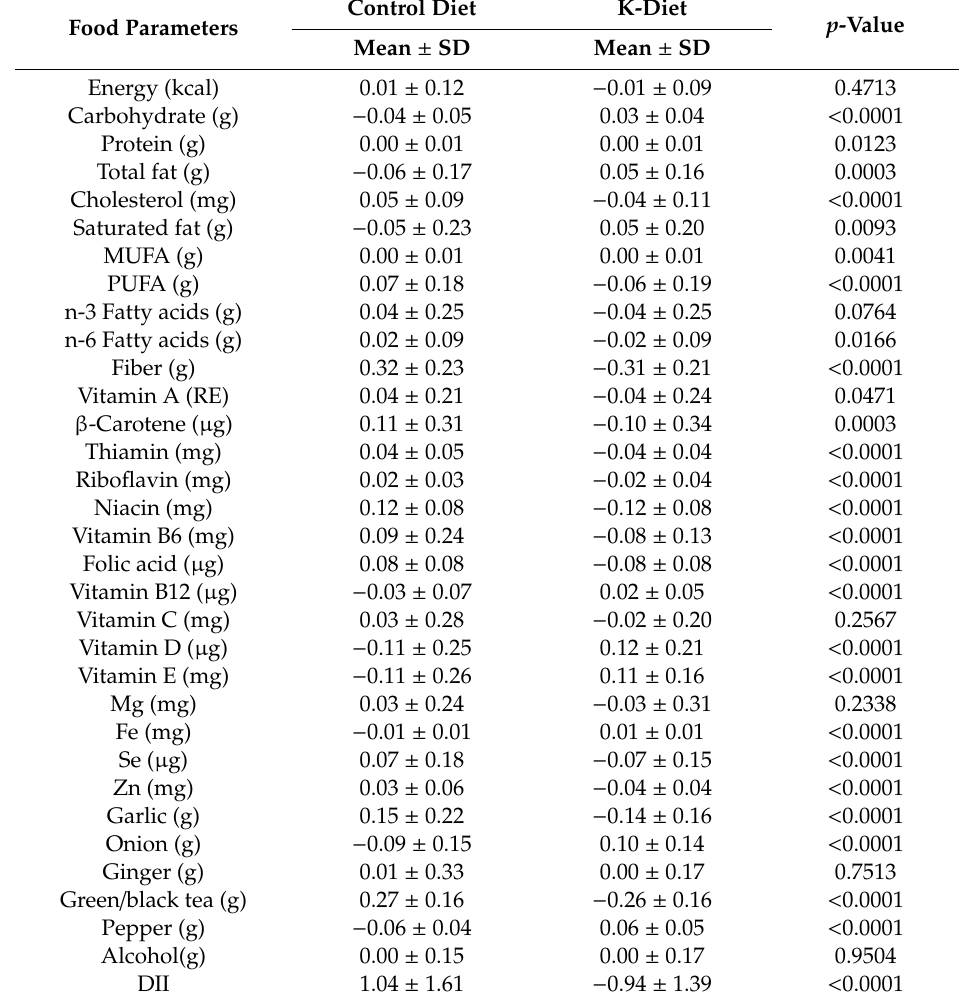
Table 1. Comparison of dietary inflammatory index (DII) between control and Korean diet (K-diet). Food